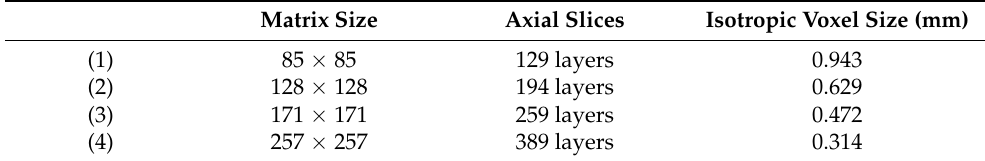
Figure 2. The internal view of a PET detector box, which contains two crystal modules, and each crystal module contains four crystal arrays. Table 1. Four different reconstruction parameter